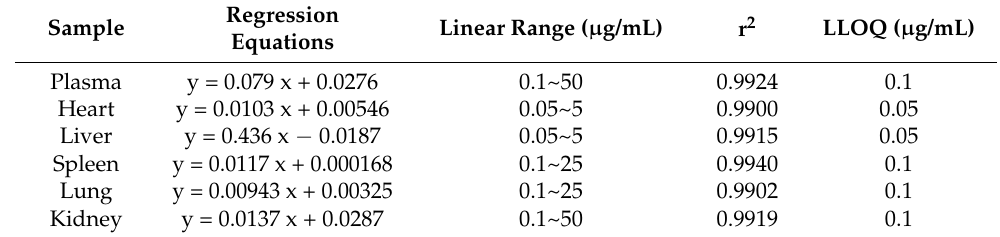
Table 2. Standard curves of acipimox in plasma and tissue of rats.